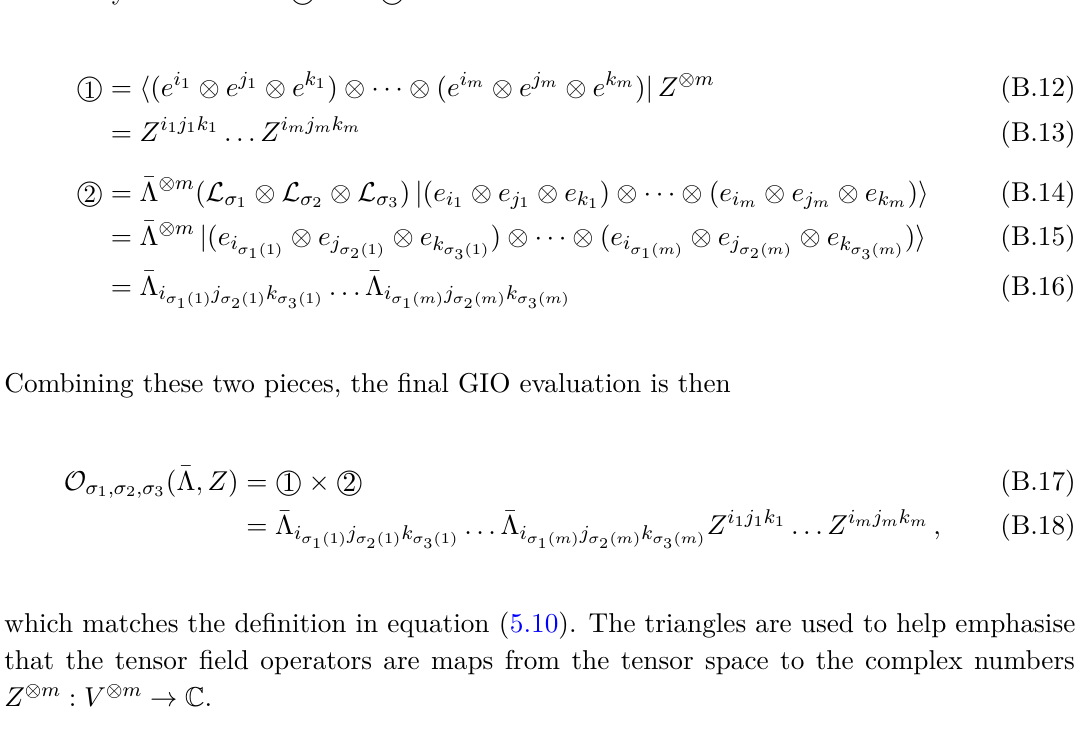
Figure 9 . A diagram representing a single gauge invariant tensor operator O σ quantum fields Z and classical witnesses ¯Λ . It can be decomposed into two parts: 1 (cid:13) where Z ⊗ m acts on a bra state and 2 (cid:13) where the linear permutation operators act first on a ket state, followed by ¯Λ ⊗ m